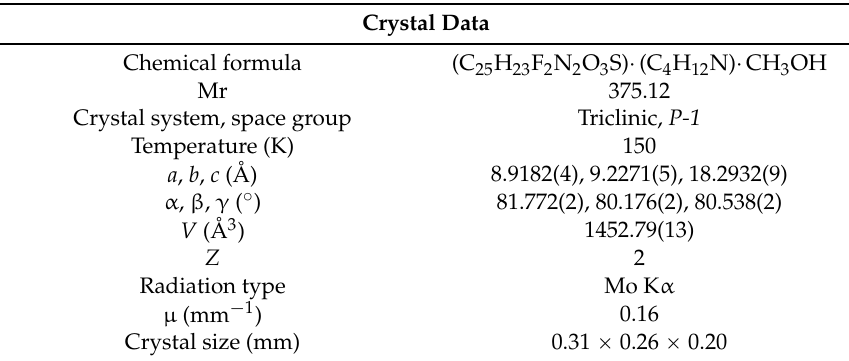
Table 1. Crystal data, data collection and refinement.